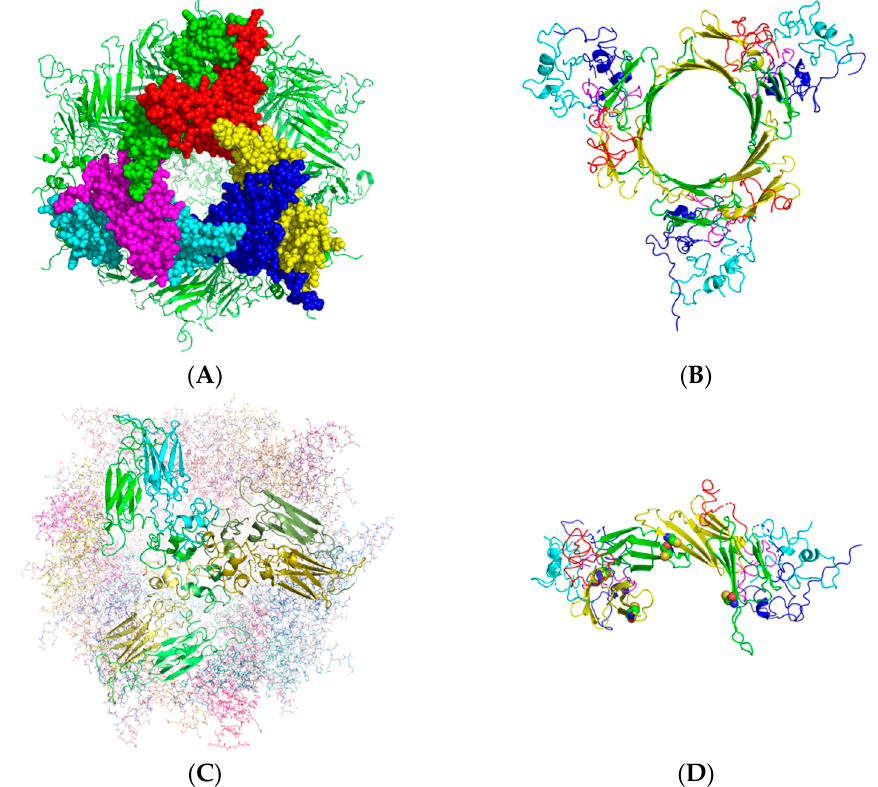
Figure 2. Crystal structure of human HspB1. ( A ) 24-mer structure. A hexamer is shown as the space- filling model. ( B ) Structure of a hexamer. Blue and Cyan—NTDs, Green and Yellow— α -crystallin domains, Red and Magenta—CTEs. ( C ) Three hexamers were assembled by the interaction of NTDs. Dimers in three hexamers, shown as ribbon models, interact via NTDs (ribbon model). ( D ) Location of cysteine residues at the interface between dimers. The structures of the two dimers are shown in the ribbon model. Cysteine residues are shown as space-filling model.